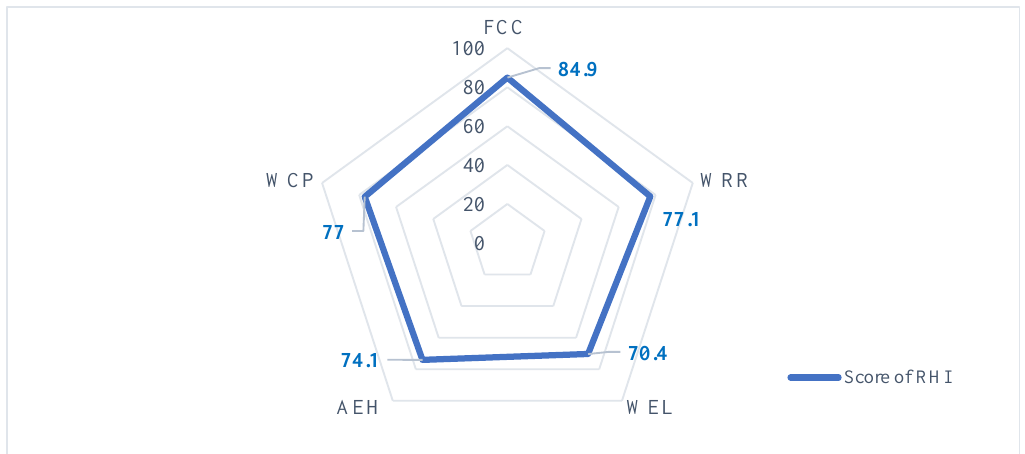
Figure 7. WCP evaluation results for China’s first-grade water resource zones.